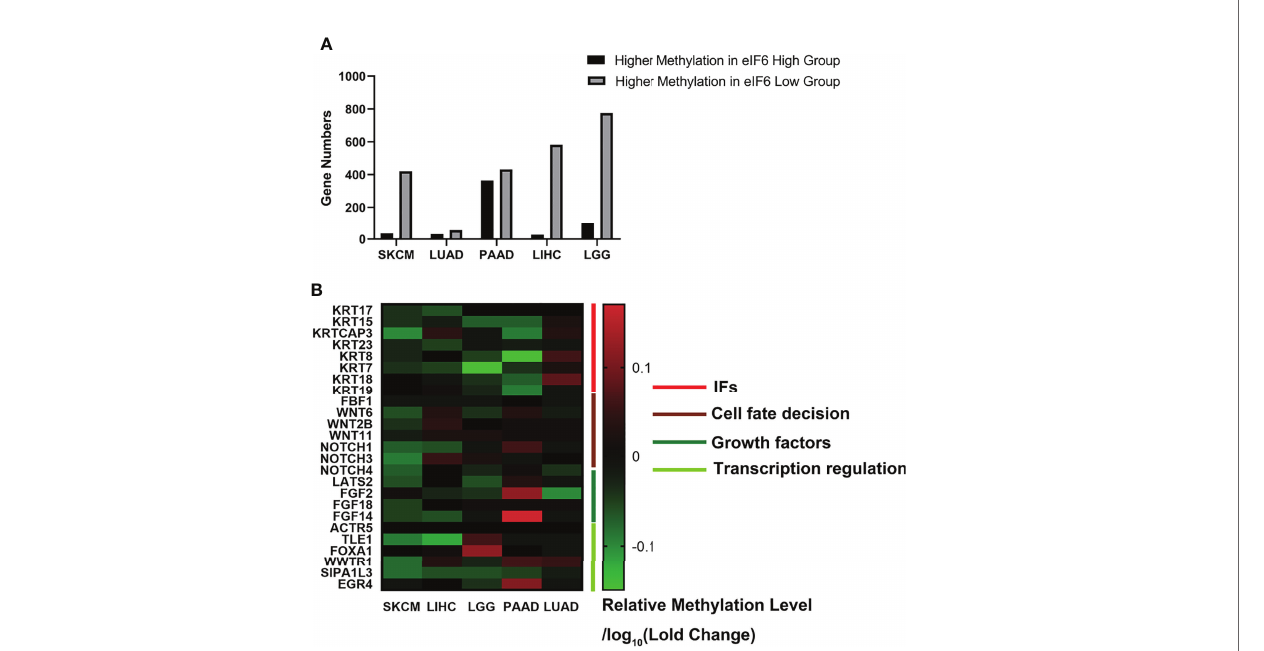
FIGURE 6 | Genome methylation analysis in pan-cancer. (A) Comparison of the differentially methylated genes between high-eIF6 and low-eIF6 groups. In all the fi ve cancers analyzed, the low-eIF6 groups had more genes with higher methylation levels than the high-eIF6 groups. (B) Heat map of differential methylated genes. The heat map was drawn according to the genes relative methylation level of the eIF6-high group compared to the eIF6-low groups. The demethylated genes were labeled with green. Upregulated keratins were identi fi ed as demethylated genes, including KRT17, KRT15, KRT23, and KRT7. Genes functioned in cell fate decisions, and cell growth was also found